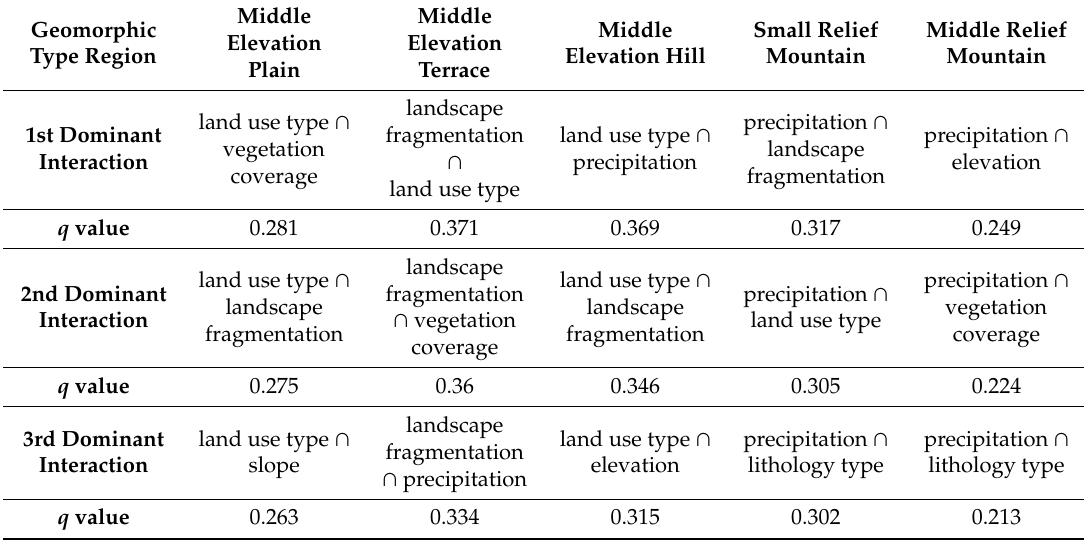
Table 4. The e ff ects of the dominant interactions of two covariates on the total river runo ff of the di ff erent geomorphic types.